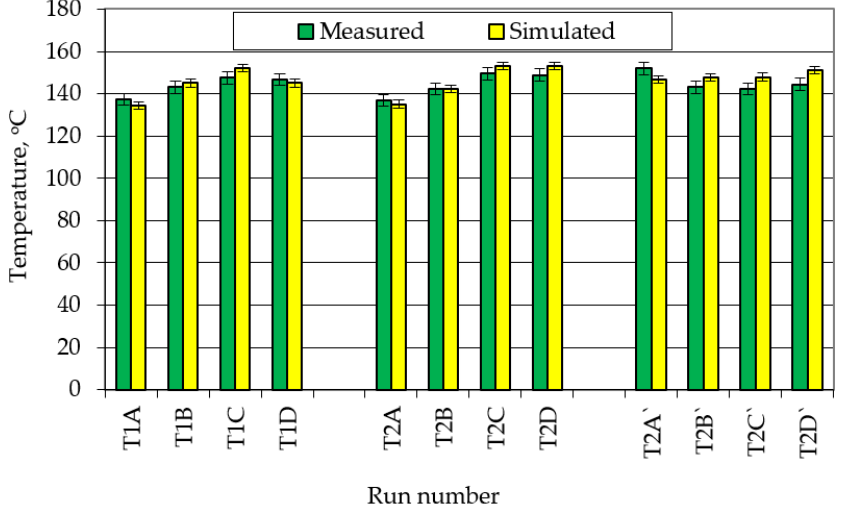
Figure 17. Results of experimental and modeling final steam temperature.